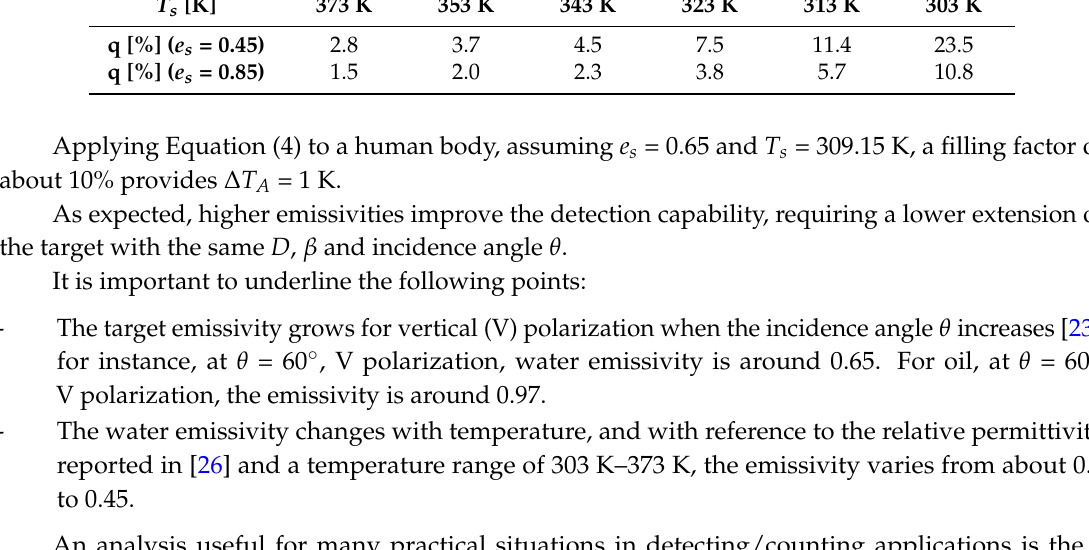
Table 3. Filling factor estimation for ∆ T A = 1 K at different target physical temperatures ( T s ) and with the same environmental conditions ( T bkg and T env ) of Table 1.